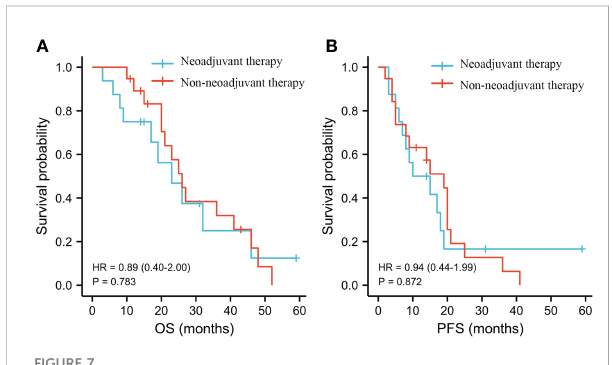
FIGURE 7 In fl uence of neoadjuvant therapy on the OS and PFS of patients. (A) OS. (B)